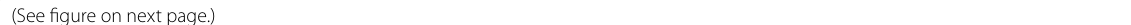
figure on next Fig. 5 Correlation of the miRNAs, with dissimilar variance in plasma ( A ) and EVs ( B ) between control and ALL survivors, with echocardiography parameters. The miRNAs without significant correlation were removed. Non‑significant correlation is presented as white blocks. LVID left ventricular internal dimension in systole (s) or diastole (d), LVEF left ventricular ejection fraction, SV left ventricular stroke volume, IVSs septal wall thickness, PWs left ventricular posterior wall thickness, RVID right ventricular internal dimension, TAPSE tricuspid annular plane systolic excursion, LA area‑left atrial area, RA right atrial